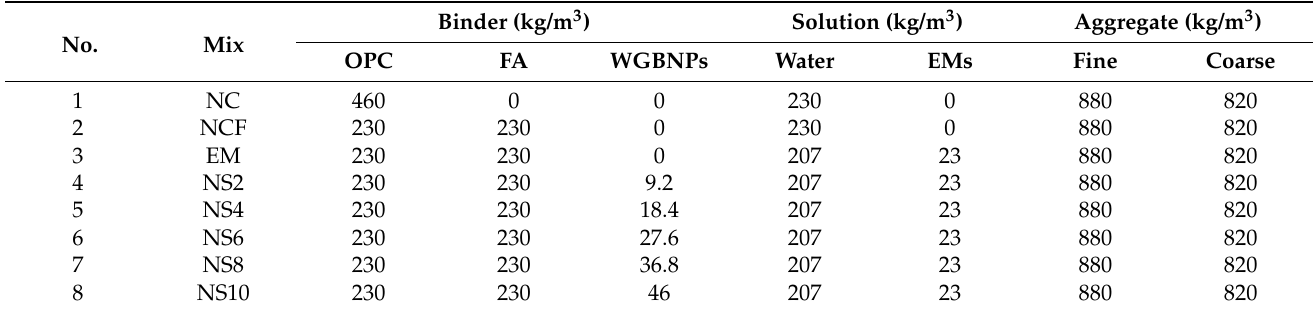
Table 3. Mix design